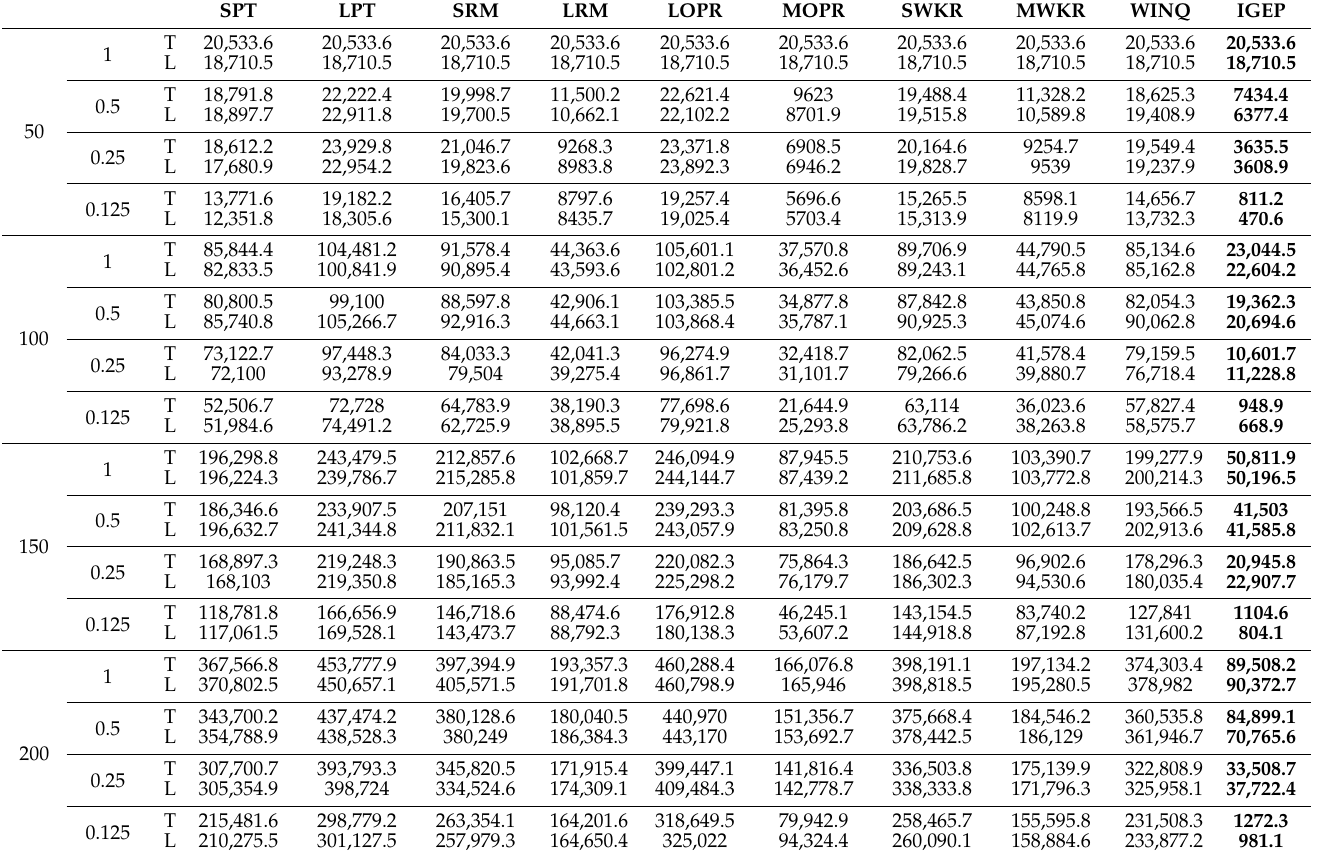
Table 6. Comparison of discovered/combination rules with minimum